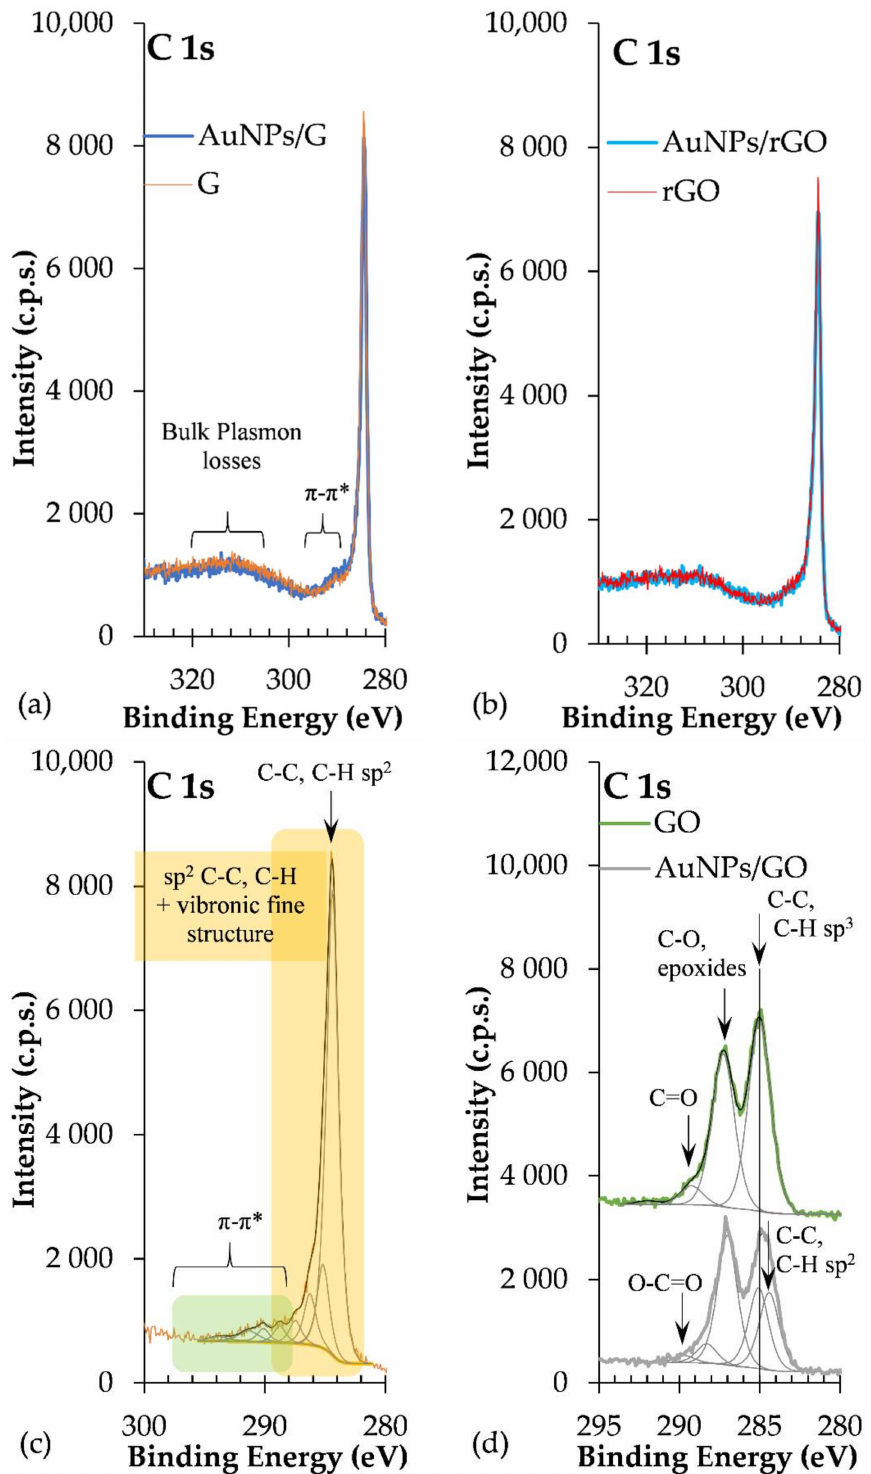
Figure 6. C 1s regions of ( a ) AuNPs/G and G; ( b ) AuNPs/rGO and rGO; ( c ) G with fitting (similar to rGO and AuNPs/rGO and AuNPs/G); and ( d ) GO and